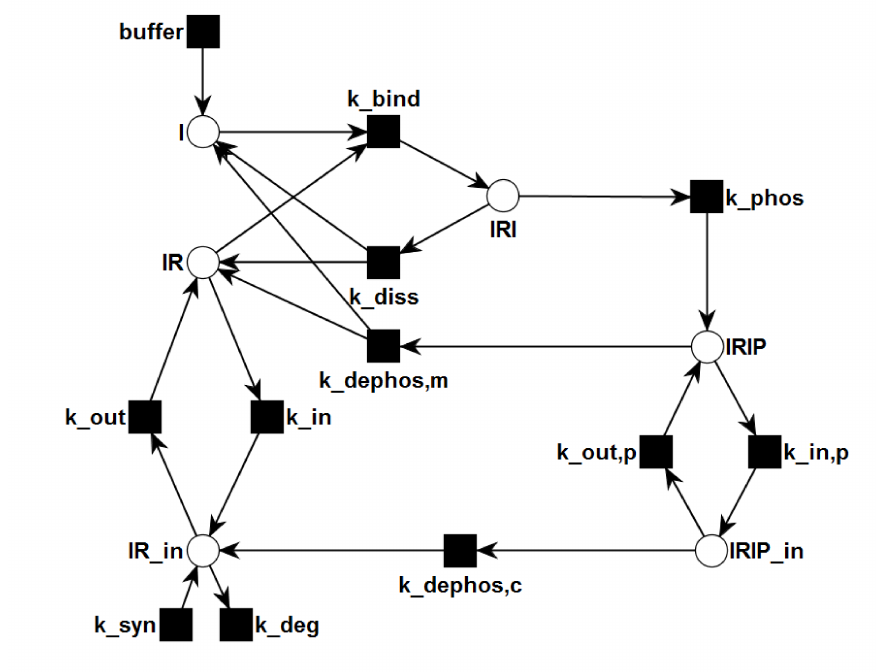
Figure 2. The PN describes the topological network structure of insulin dependent activation and recycling. Rectangles represent transitions, i.e. , reactions. Places are plotted as circles. Directed, weighted edges connect transitions and places. The places represent chemical species, e.g., insulin, receptors, or complexes, and can carry tokens, which represent discrete amounts of the chemical species. Transitions can consume tokens from the pre-places and generate tokens on the